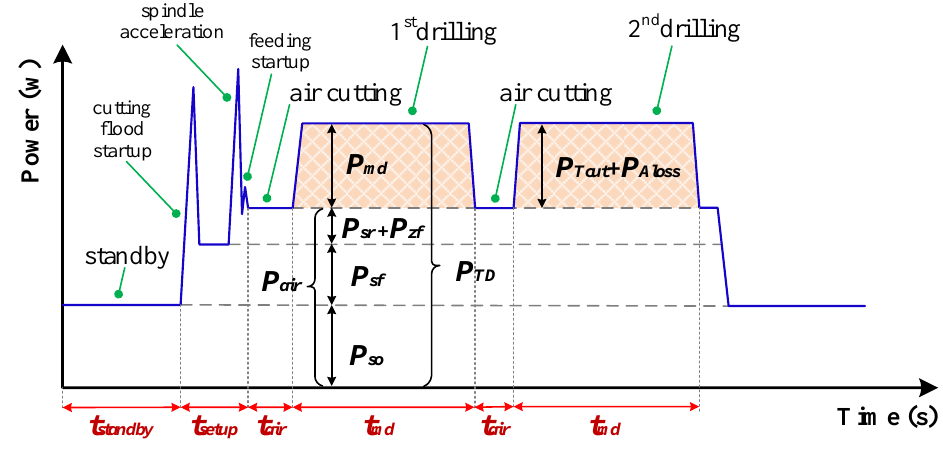
Figure 4. Power profile of a machine tool during drilling processes.